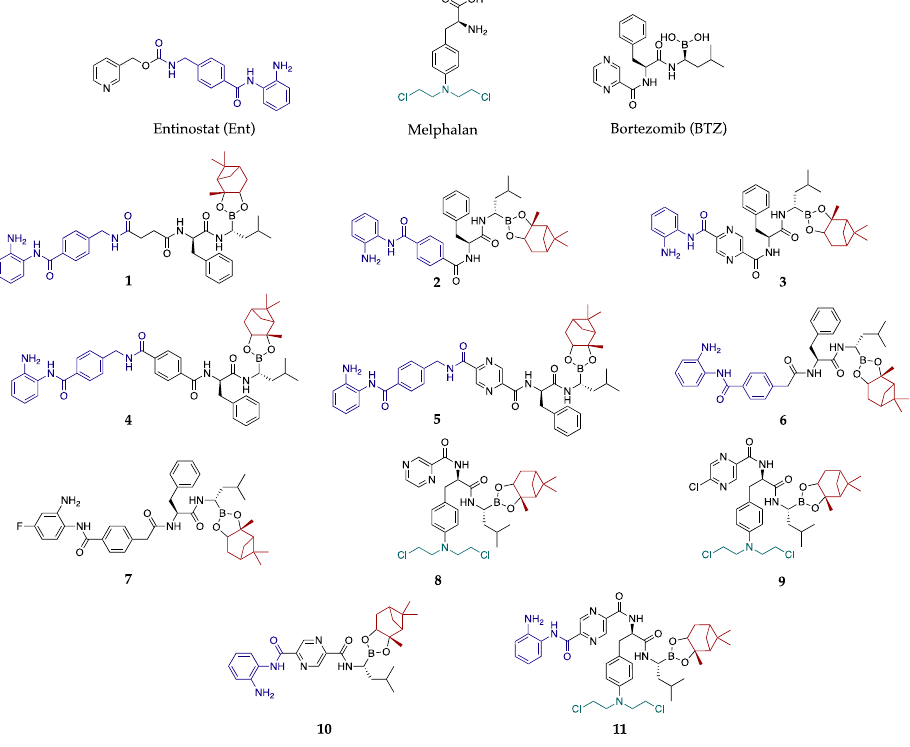
Figure 1. Structures of hybrid HDACi-BTZ compounds 1 – 11 .